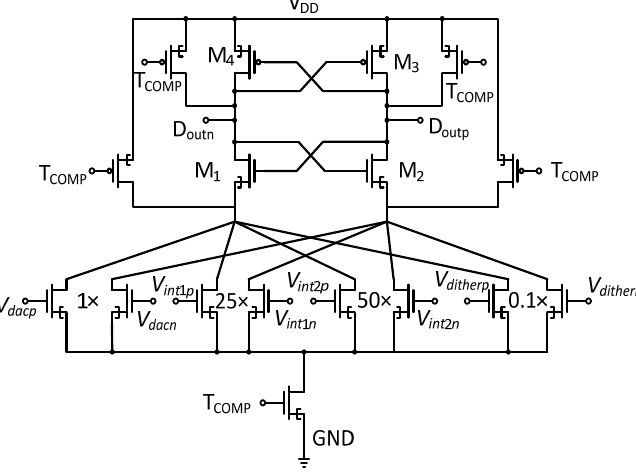
Figure 25. The comparator circuit used in the NS Δ Ʃ SAR ADC.